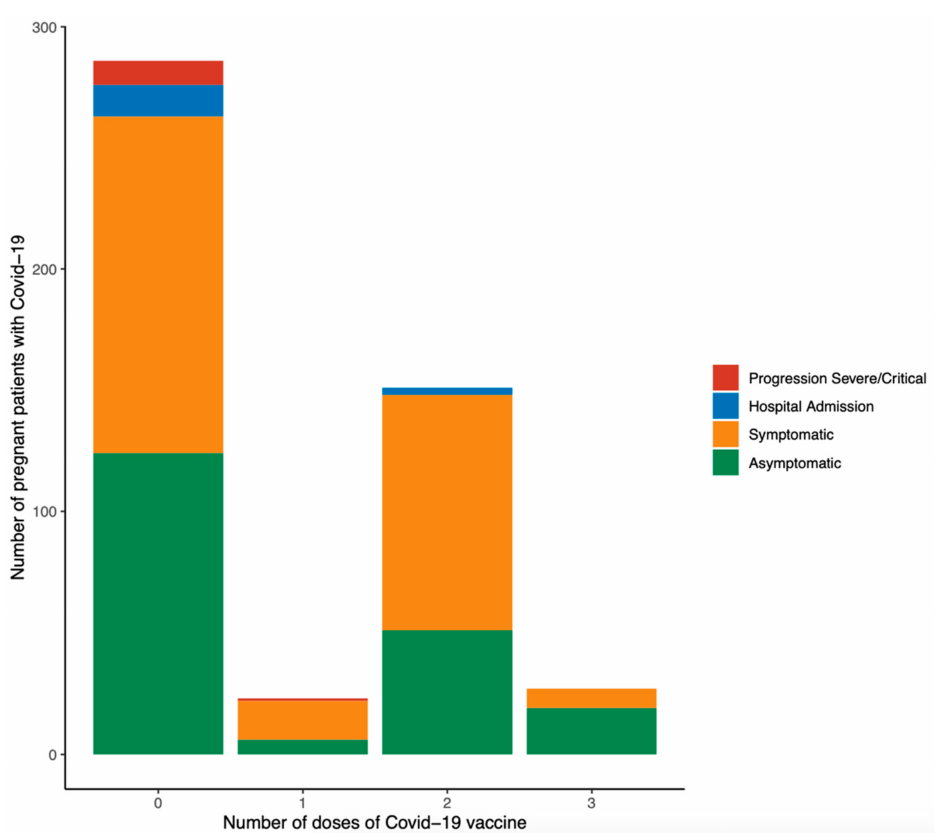
Figure 3. Progression to severe COVID-19 among vaccinated pregnant women with SARS-CoV-2 infection according to the number of doses of COVID-19 vaccine. Severe COVID-19 was defined as at least one of the following: admission to the intensive care unit, intubation, or extracorporeal membrane